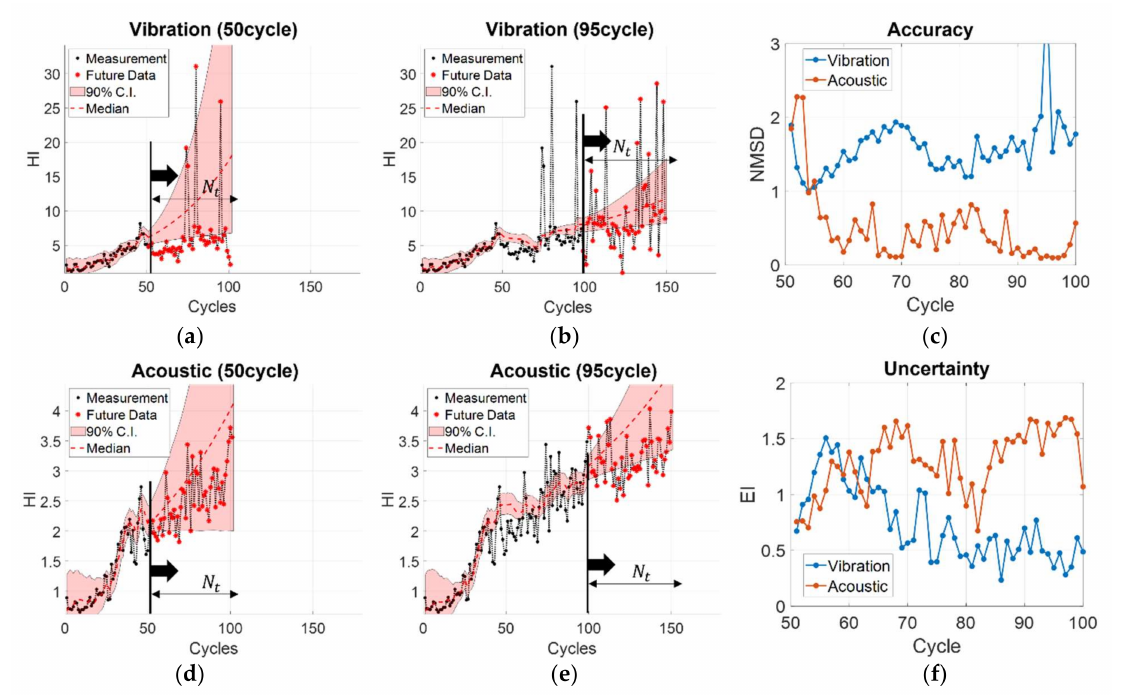
Figure 8. Prediction by the vibration sensor for RTF No.1 data at ( a ) 50cycle and ( b ) 95cycle; ( c ) NMSD calculated at each cycle from 50 to 95 cycles; Prediction by the acoustic sensor for RTF No.1 data at